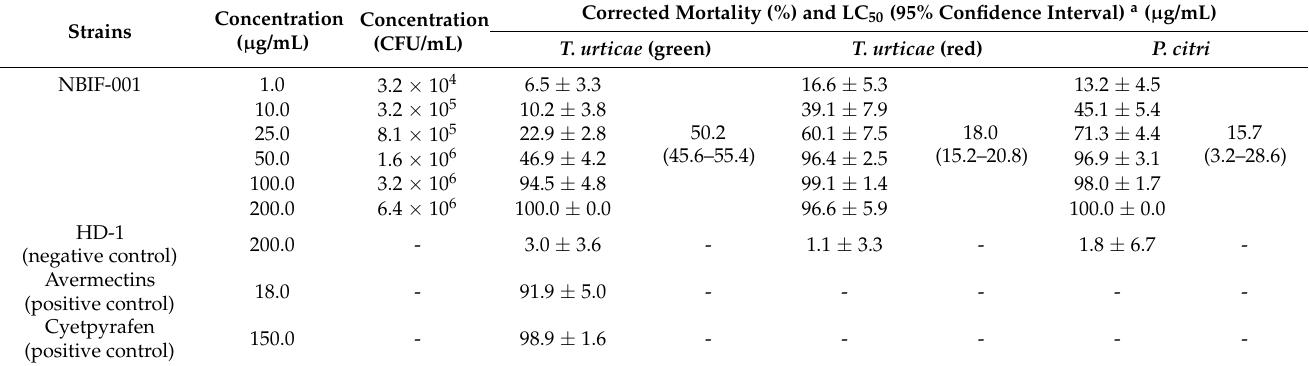
Table 1. Acaricidal activity of Bacillus vallismortis NBIF-001 and B. thuringiensis HD-1 (control) against Tetranychus urticae (green and red) and Panonychus citri